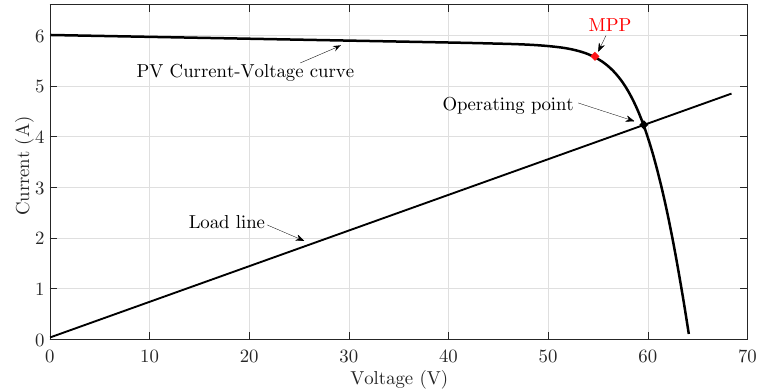
Figure 2. Typical current–voltage curve for a PV